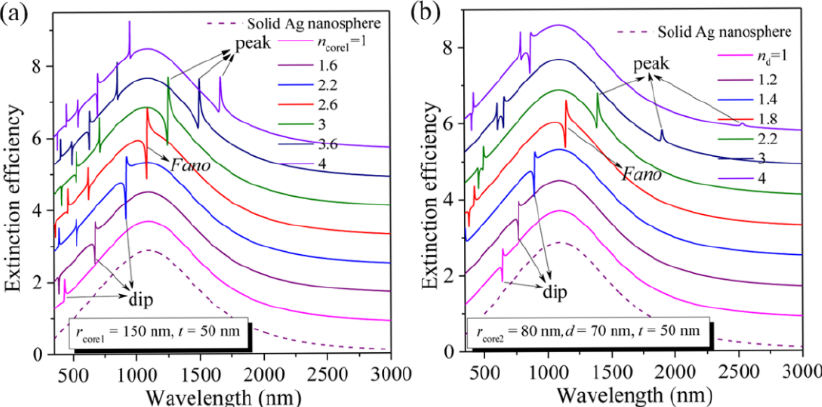
Figure 3. ( a ) Calculated extinction efficiency spectra ( a 1 ) for an Ag nanoshell ( r core1 = 150 nm) with different n core1 from 1.0 to 4.0 (each spectrum vertically offset by 0.8 for clarity). ( b ) Calculated extinction efficiency spectra ( a 1 ) for an Ag nanomatryushka ( r core2 = 80 nm, d = 70 nm) with different n d from 1.0 to 4.0 (each-spectrum vertically offset by 0.8 for clarity).